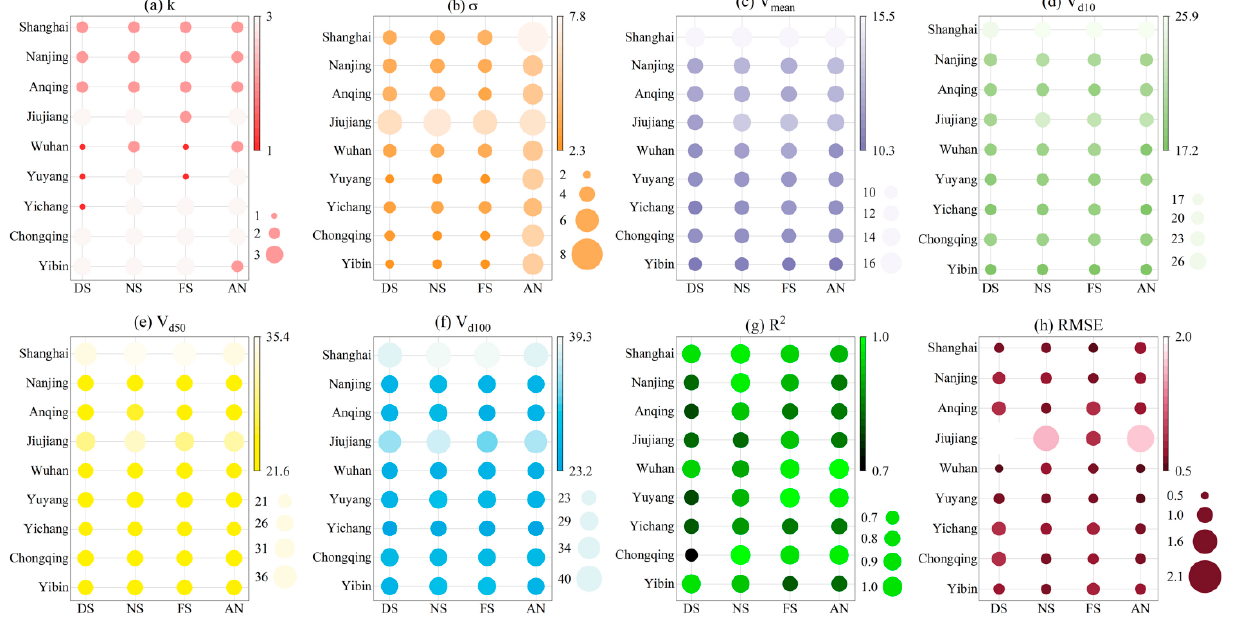
Figure 6. (a-h) Goodness-of-fit tests for the GEV distribution and 10/50/100 engineering design wind speeds (DS = dry season, NS = normal season, FS = flood season and AN = annual) for nine ports from 1979 to 2020.